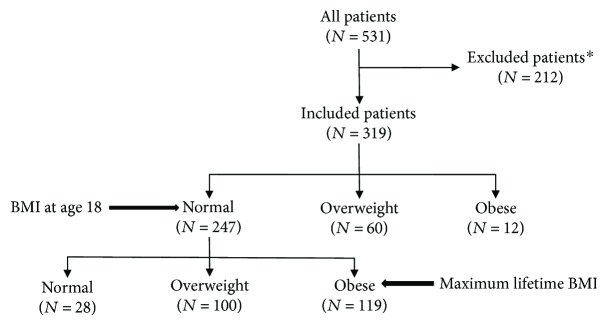
Patient distribution. ∗Patients excluded due to incomplete covariate data or BMI at age 18 <18.5 kg/m2.